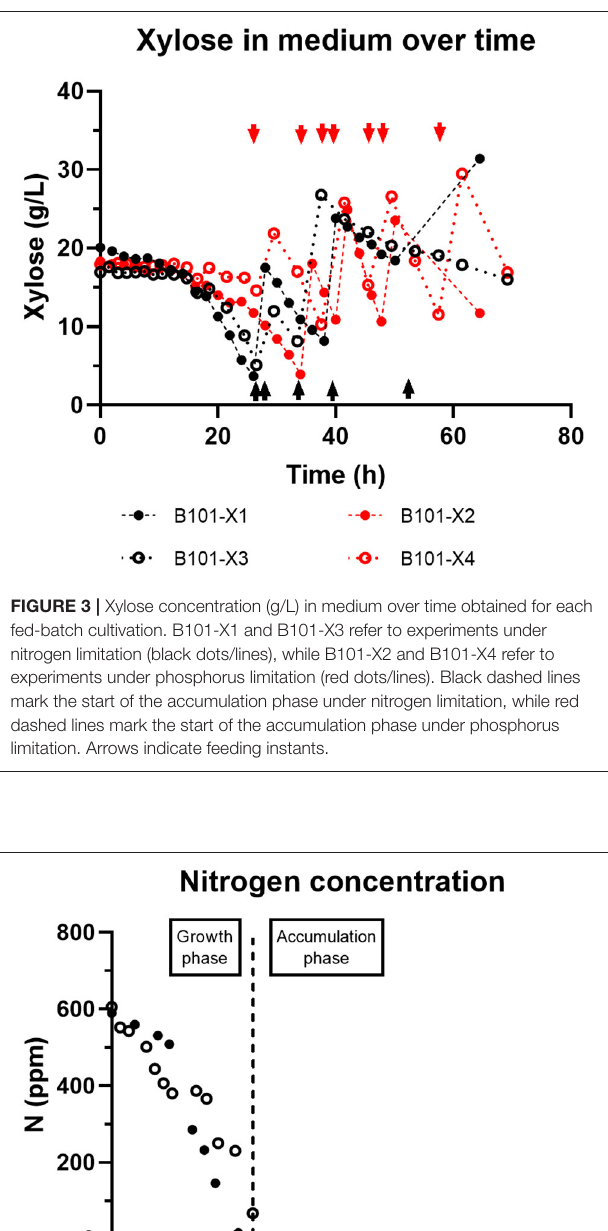
operon, and polyphosphate kinase genes. BLAST tool (Altschul et al., 1990) was used to confirm annotation and to compare protein sequences with Escherichia coli . Promoter sequences were predicted using Softberry BPROM (Solovyev and Salamov, 2011).